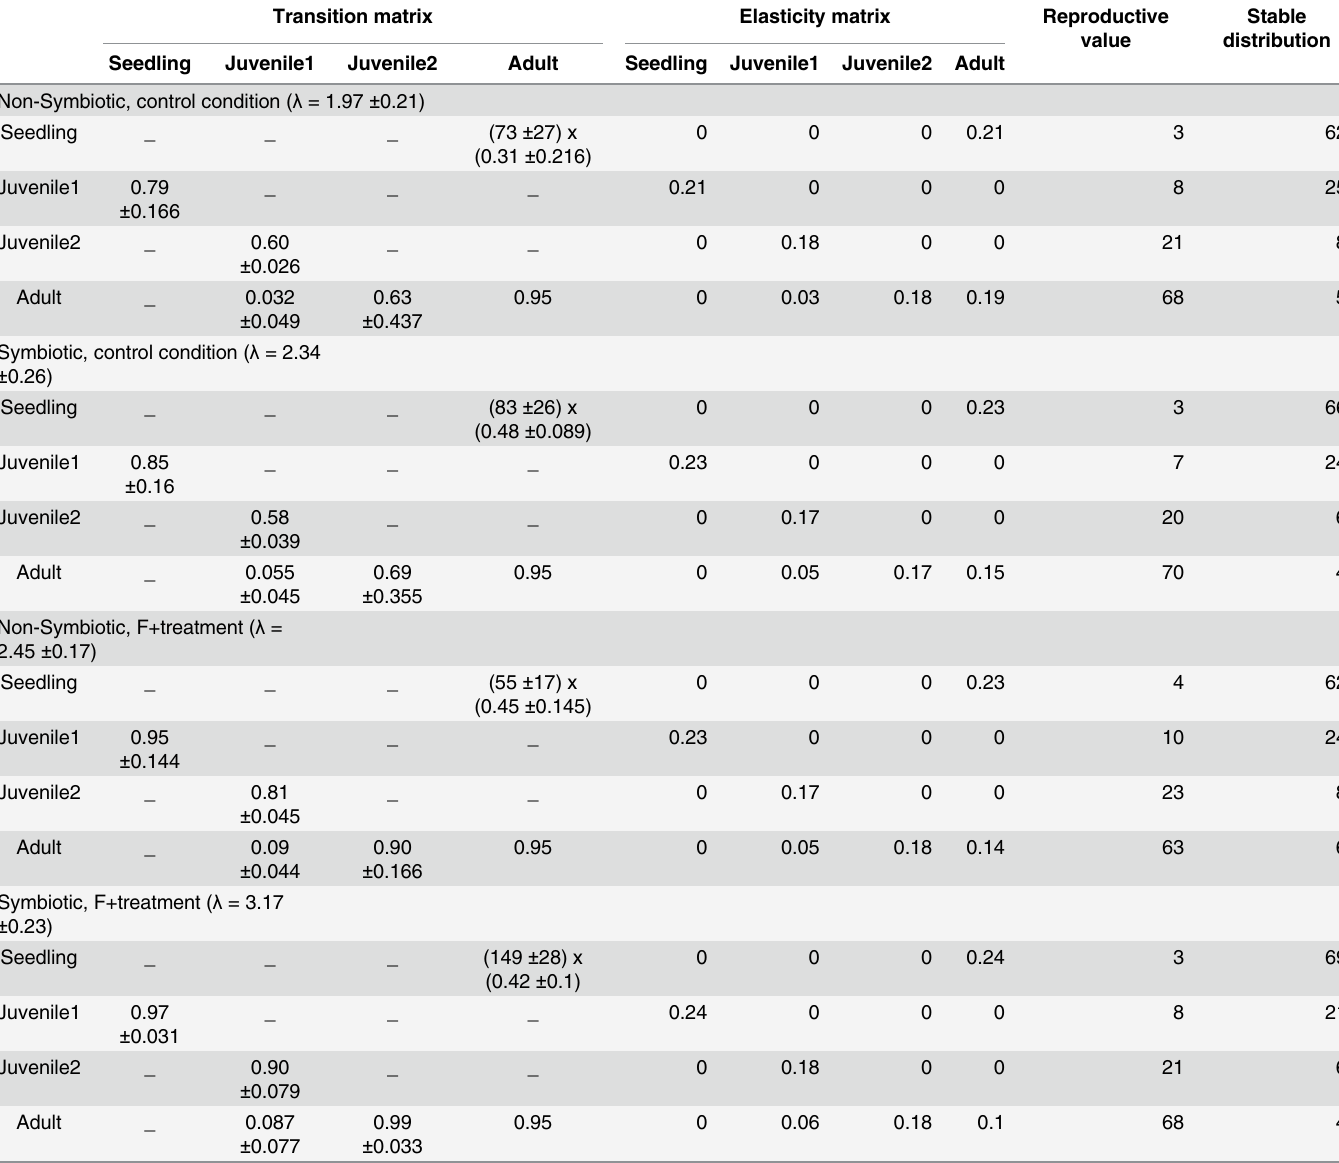
Table 4. Transition, elasticity matrices, reproductive values and stable distribution across stages of Festuca eskia as a function of endophyte sta- tus and edaphic resource level. The transition matrices for each set of conditions contain the life-cycle stage and the probabilities. The values shown are means ± SEM. F+treatment: addition of fertilizer. Λ : asymptotic population growth rate calculated by Monte Carlo